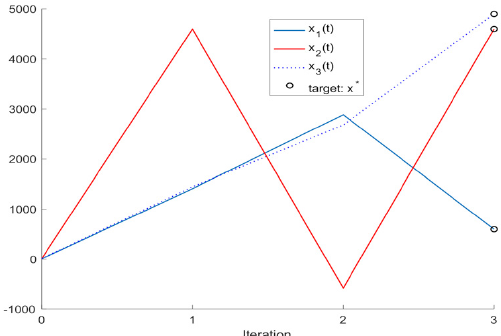
Figure 1. Evolution of stock vector x t under the control law (24) in Example 1.